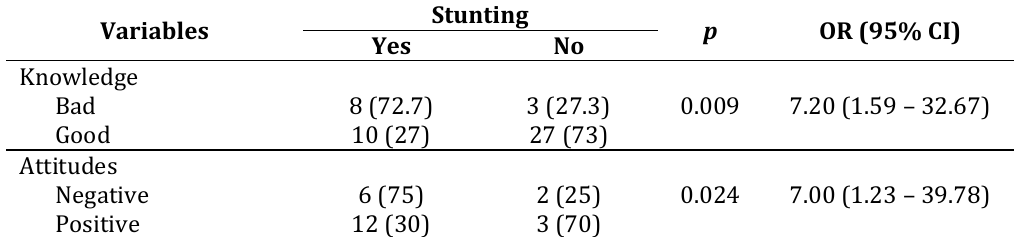
The relationship of respondents’ knowledge and attitudes towards stunting evidence